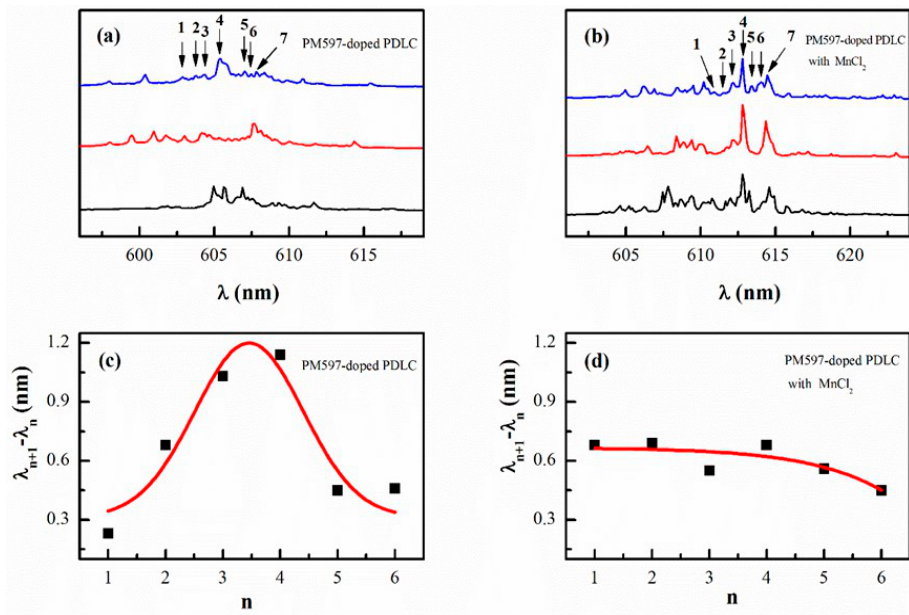
Figure 5. Single-shot emission spectra at different time with same pumped position, same pumped area ( A ~ 0.54 mm 2 ) and same pump energy for ( a ) PM597-doped PDLC (14.25 μ J) and ( b ) PM597-doped PDLC and 0.1 mL MnCl 2 (7.65 μ J), respectively; ( c , d ) Mode separation of adjacent modes versus the lasing mode derived from ( a , b ), respectively.